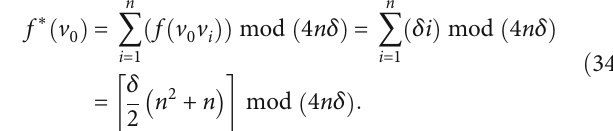
− graceful labeling, and G 9 with edge 4